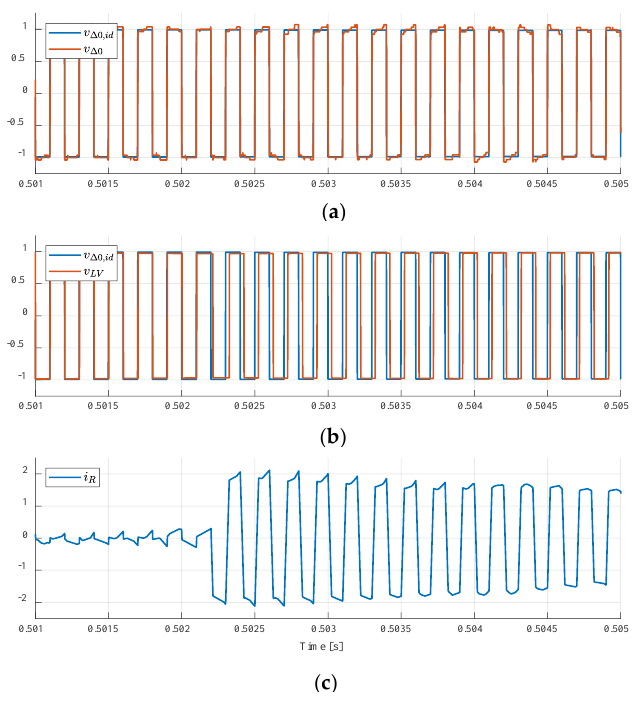
Figure 8. Behavior in correspondence of 0 kW to 100 kW step variation of the actual MMC differential homopolar output compared with its mean value ( a ) of the transformer voltages ( b ) and of the transformer current ( c ).